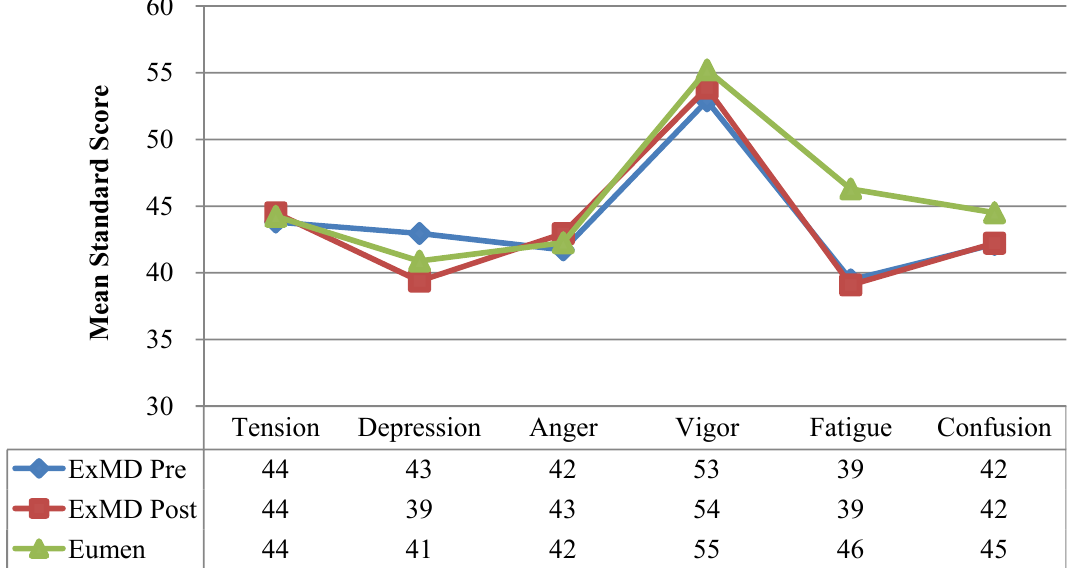
Figure 3. Profile of Mood State Profile in women with Eumenorrheic and ExMD at pre/post-intervention. Please provide the original figure format, like Figure